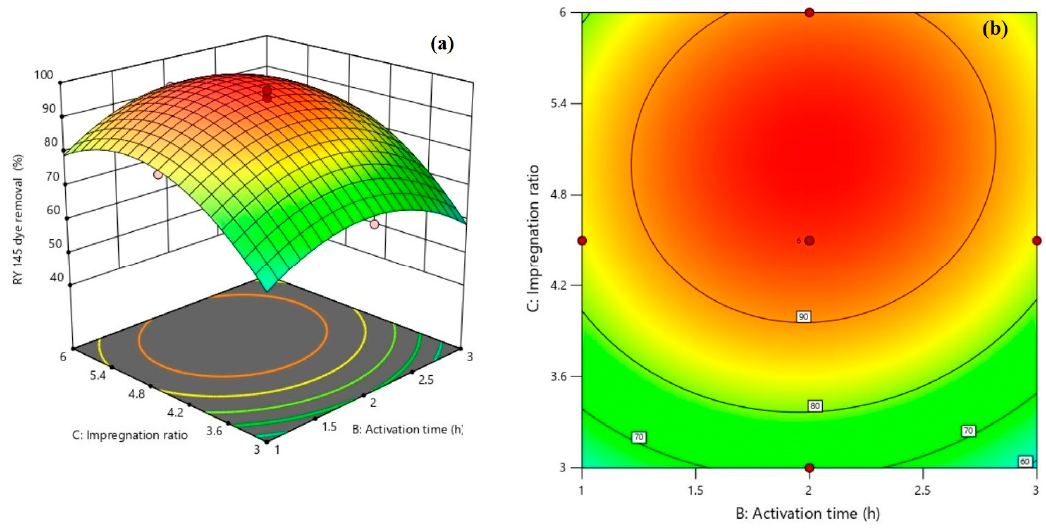
Figure 6. Response surface plots for the e ff ects of H 3 PO 4 used and heating time on the 3D response ( a ) and its corresponding counter plot ( b ).